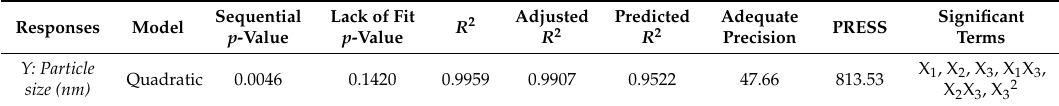
Table 3. Fit model statistics of FBX-EMLs responses prepared according to Box-Behnken design.